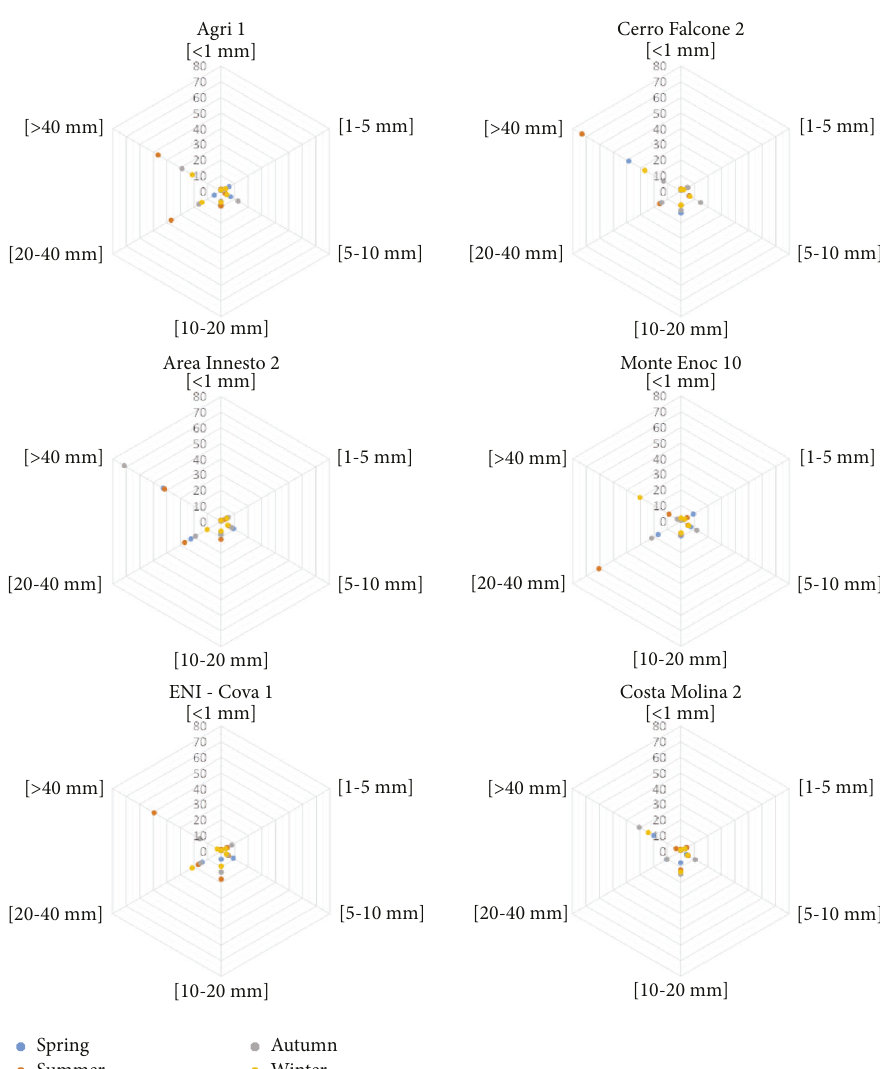
Figure 13: Seasonal MAE for precipitation thresholds in the two years of the observation period over the six weather stations at day +1 as lead time for the KALM-HD model with